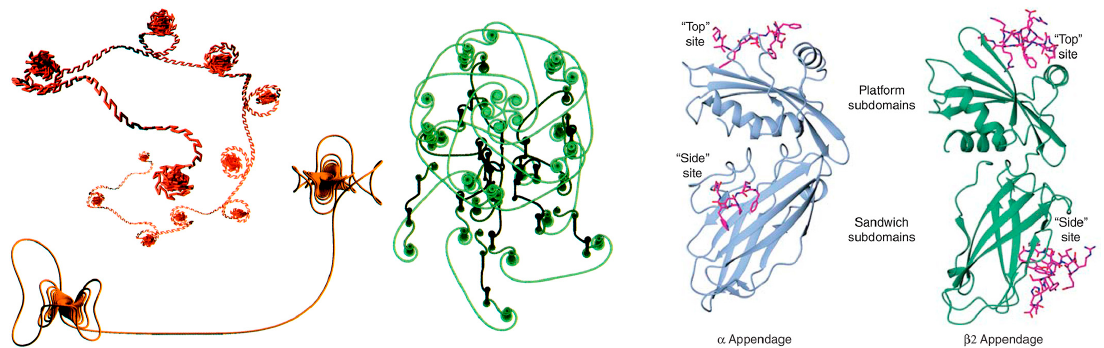
Figure 2. “Fractal Ghirigors” in the space generated by tortuous curves, geometric schemes compared with the synthetic representation of the proteins AP2 appendage of the clathrin protein [7] (p. 263), [8] (p.